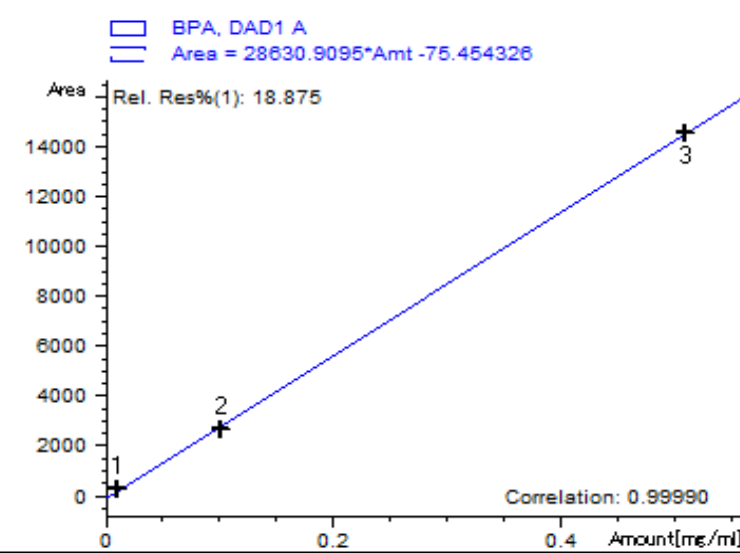
Figure 1. Bisphenol A calibration curve.